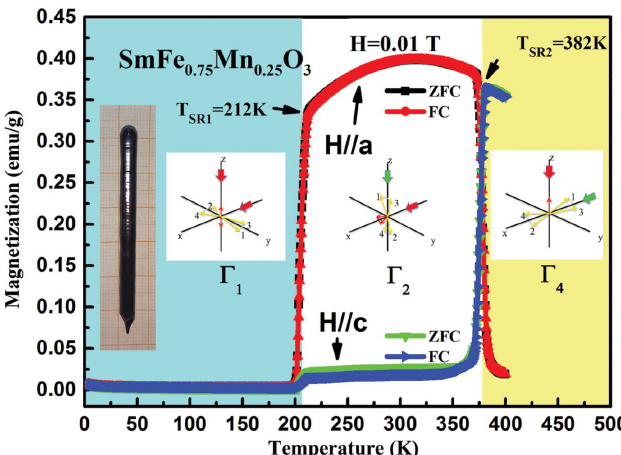
Figure 2 Temperature-dependent magnetizations of SmFe 0.75 Mn 0.25 O 3 along the a and c axes under magnetic field H = 0.01 T. Three slightly canted antiferromagnetic phases (cid:2) 1 , (cid:2) 2 and (cid:2) 4 can be distinguished by the shaded areas. The inset shows the SmFe 0.75 Mn 0.25 O 3 single-crystal sample.